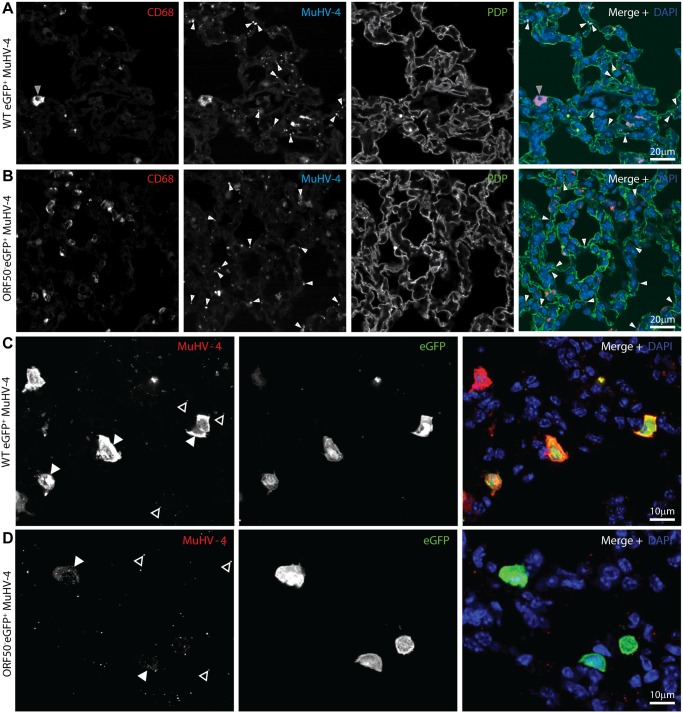

In vivo MuHV-4 binding and uptake.
A. C57BL/6 mice were infected i.n. (105 p.f.u.) with eGFP+ MuHV-4. 1 day later lung sections were immunostained for CD68 (red in merge), virion antigens (cyan in merge) and PDP (green in merge). Nuclei were stained with DAPI (blue in merge). Significantly more isolated antigen+ dots (virions, white arrows) associated with PDP+ AECs than with CD68+ macrophages (p<10-6 by Student’s 2 tailed unpaired t test); but more antigen+ cells (grey arrow) were macrophages (p<10-6). The images are representative of sections from 3 mice. B. C57BL/6 mice were infected i.n. (105 p.f.u.) with ORF50- eGFP+ MuHV-4. 1 day later lung sections were stained as in a. Again, significantly more isolated antigen+ dots (white arrows) associated with PDP+ AECs than with CD68+ macrophages (p<10-6 by Student’s 2 tailed unpaired t test). C. Lung sections of mice infected as in a were stained 1 day later for virion antigens (red in merge) and eGFP (green in merge). Nuclei were stained with DAPI (blue in merge). At this time only macrophages express new lytic antigens or viral eGFP (Figs. 1–2). Significantly more strong, diffuse lytic antigen staining (lytic infection, filled arrow) was in eGFP+ than in eGFP- cells (p<10-6 by Student’s 2-tailed unpaired t test); but significantly more isolated antigen+ dots (open arrows) associated with eGFP- cells (p<10-6). The images are representative of 9 sections from 3 mice. d. Mice were infected as in b. 1 day later lung sections were stained as in c. Input virion antigens (from input virions as this virus is replication-deficient, filled arrow) accumulated mainly in eGFP+ cells, whereas isolated antigen+ dots (open arrows) associated mainly with eGFP- cells (p<10-6).